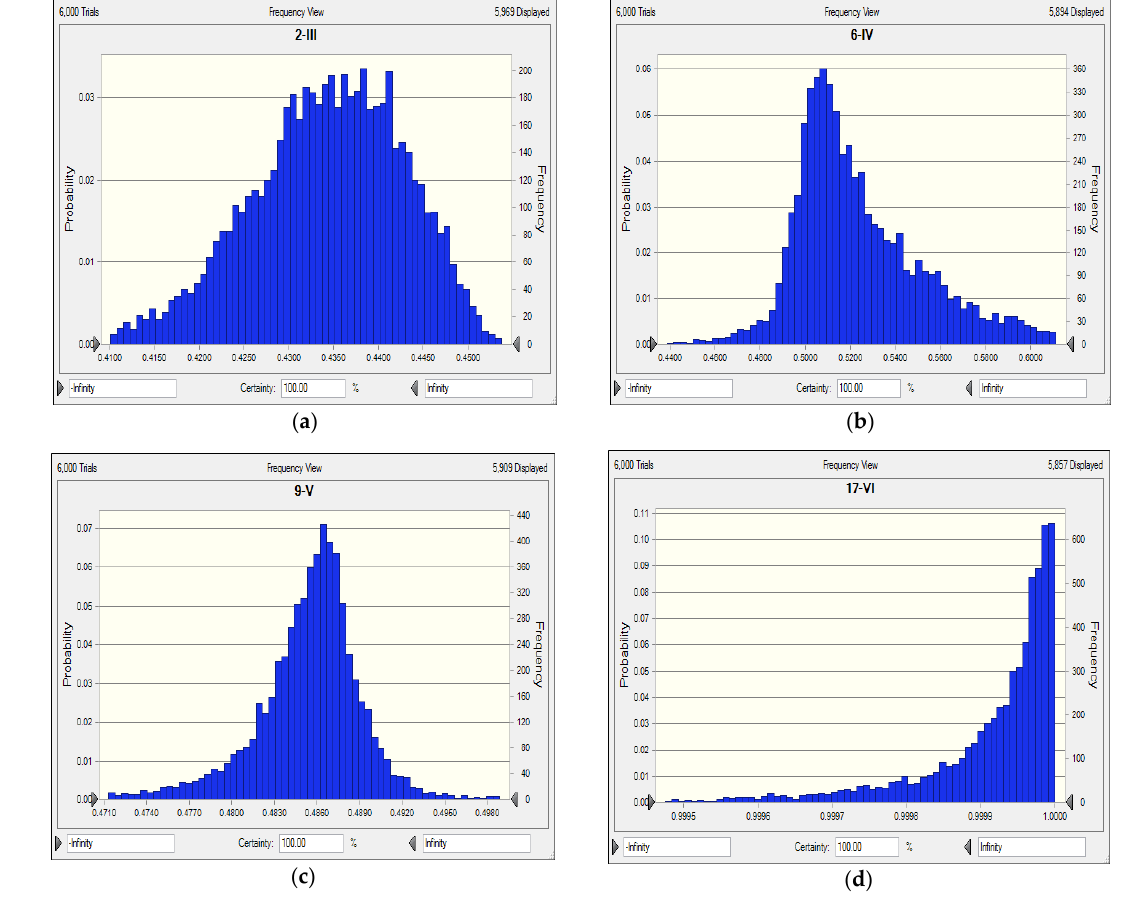
Figure 4. Distribution of certainty degree to level III, IV, V, and VI for ( a ) Distribution of certainty degree to level III for Gaoshan Lake (S2), ( b ) Distribution of certainty degree to level IV for Gucheng Lake (S6), ( c ) Distribution of certainty degree to level V for Dali Lake (S9), and ( d ) Distribution of certainty degree to level VI for Dongshan Lake (S17).